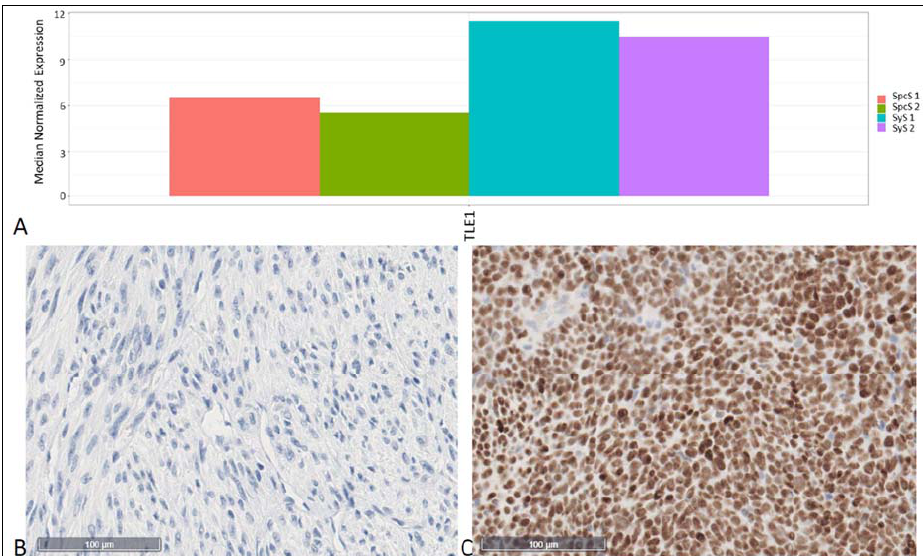
Figure 5. Different expression of TLE1 in SyS and SpcS samples. ( A ) This bar plot shows the expression (HTP analysis) of TLE in two samples of SyS and SpcS, respectively. TLE1 showed significantly higher expression in SyS ( p = 6.14 × 10 43 ). ( B , C ) IHC ‐ staining of TLE1 in SpcS ( B ) and SyS ( C ).Magnification bars in B and C indicate 100 μ m. To visualize the top 10 differentially expressed genes in SpcS and SyS, a heatmap was created (Figure 6). Yellow bars indicate SpcS samples, and blue bars indicate SyS samples. Red designates low expression, whereas blue specifies an elevated expression of genes. This heatmap visualizes the clear differences in gene expression of the 10 genes, including the established marker TLE1 for SyS.